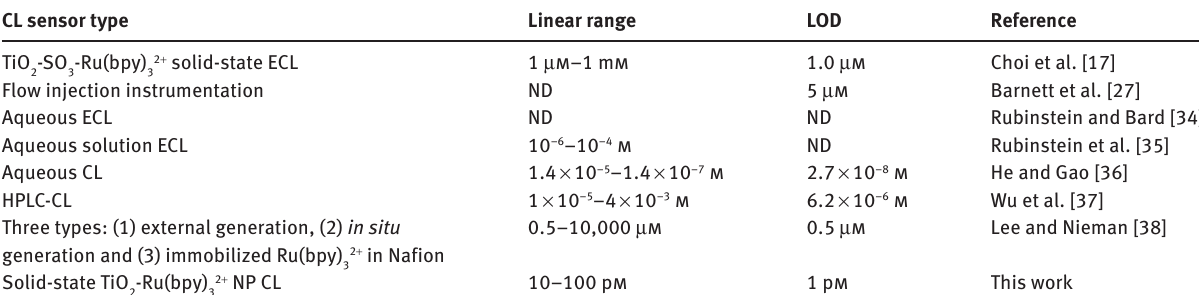
Table 2: Linear range and LOD of oxalate determined using different types of CL sensors found in the literature. CL sensor type